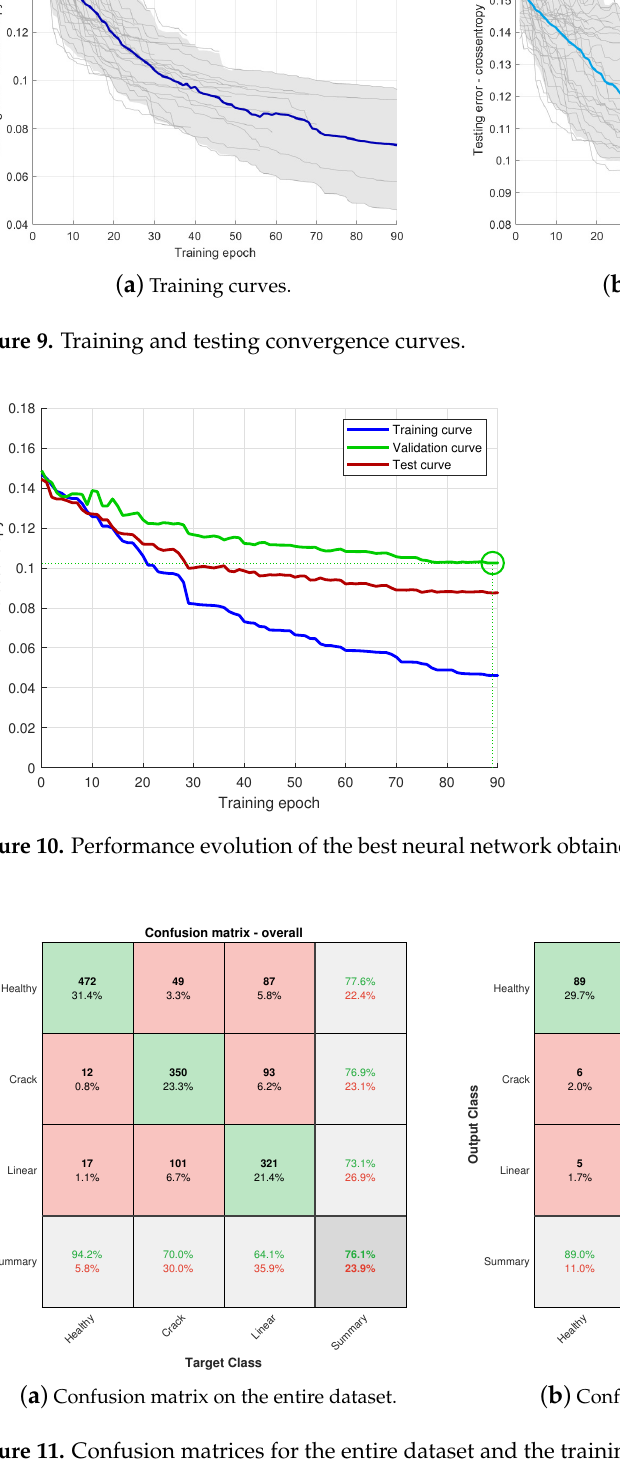
Figure 11. Confusion matrices for the entire dataset and the training